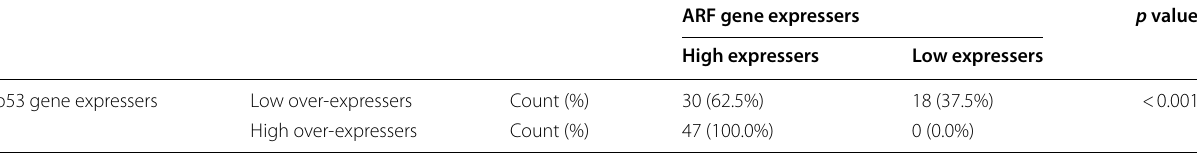
Table 3 Relation between p53 gene over-expression and ARF gene